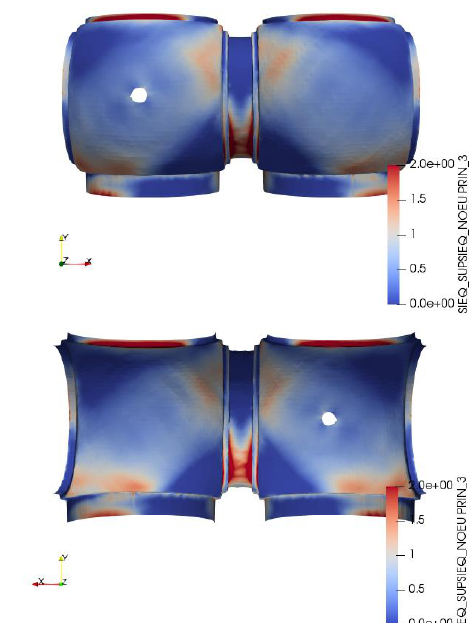
Figure 10. Distribution of the maximum principal stresses in the extrados and the intrados of the vault for an imposed 10 mm displacement of the central column.